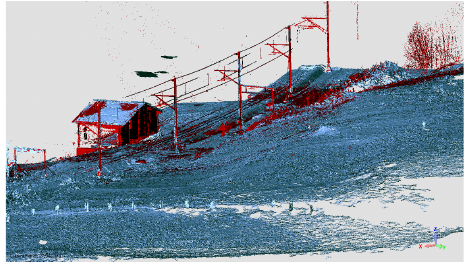
Figure 12: Niederwald automatically registered, Red/Dark: Laser, Blue/Light: Photogrammetry